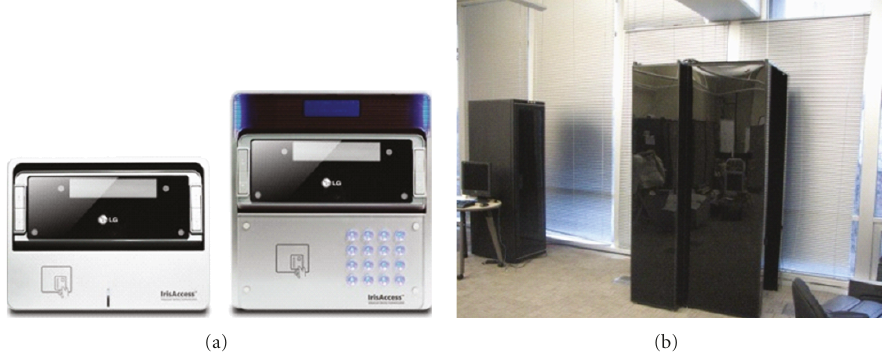
Figure 1: Two commercial state of the art iris acquisition and recognition systems (a) The LG IrisAccess4000 which uses voice prompts to direct the user to the optimal position so that an in-focus iris image may be acquired. (b) is the Iris-On-the-Move system developed by Sarno ff Corporation which captures iris images with an increased stand-o ff of 3 meters. In both (a) and (b), the reader will note that the capture volume is fixed, that is, the user is expected to be in a fixed location for iris acquisition.